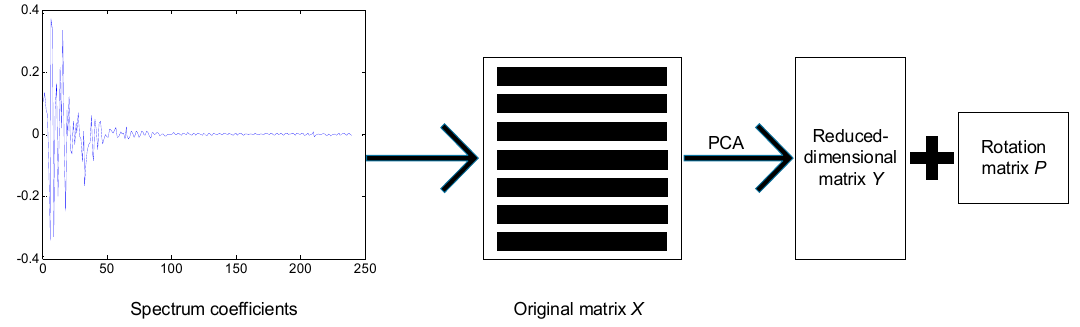
Figure 3. Scheme of PCA-based coding method. (PCA, Principle Component Analysis).